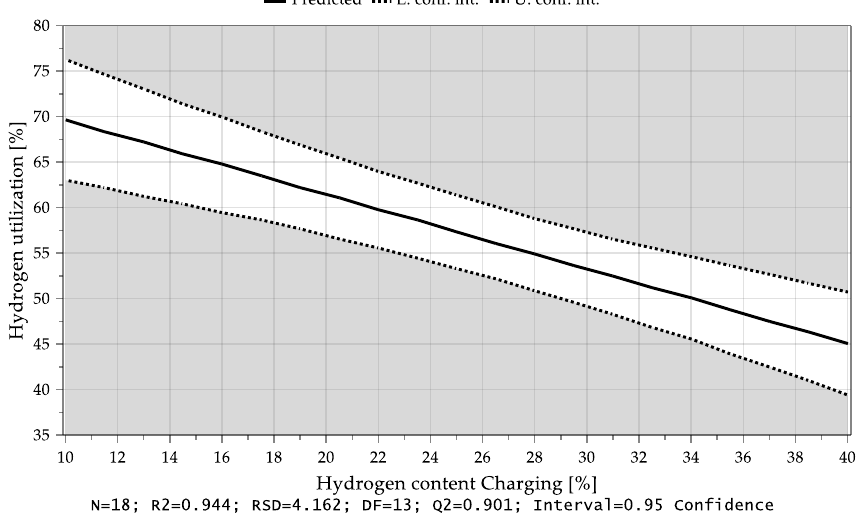
Figure 15. Average hydrogen utilization as a function of the H 2 content during iron ore charging.